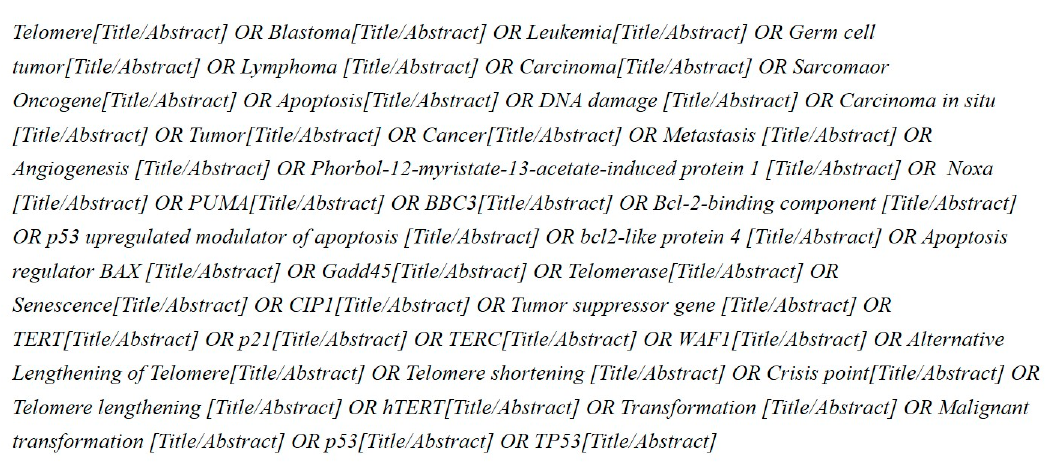
Figure 2. Search